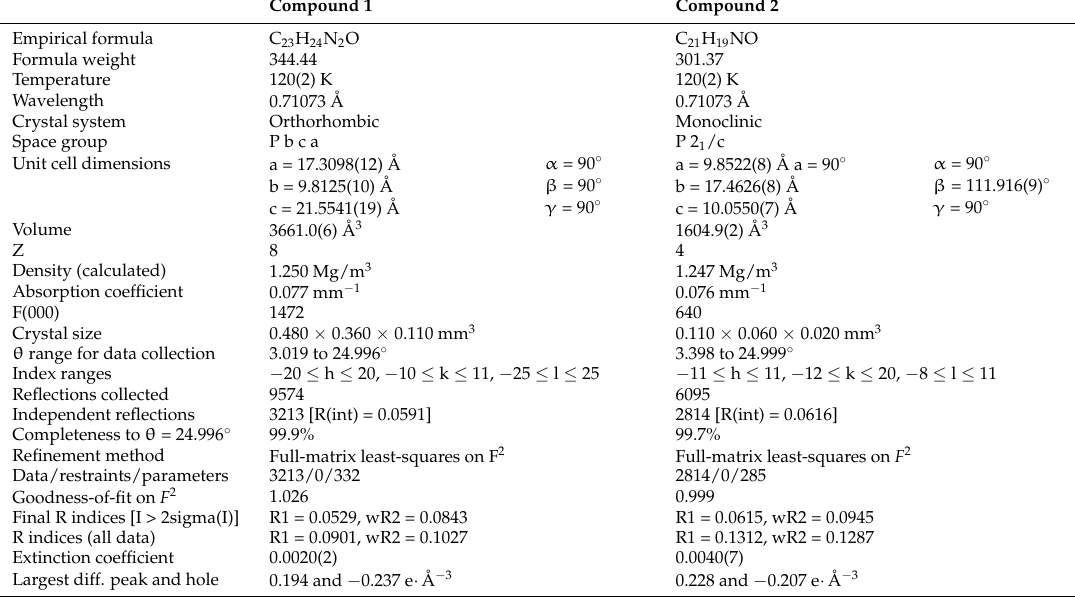
Table 6. Crystal data and structure refinement for compounds 1 and 2